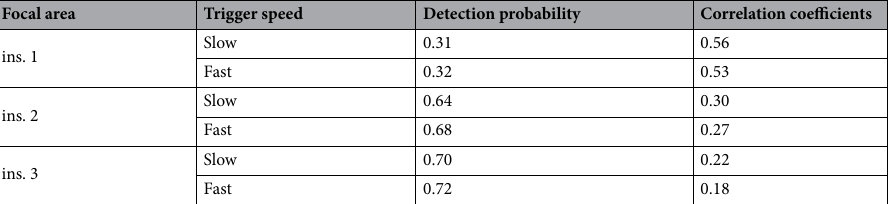
Table 2. Results of the simulations mimicking the process by which camera traps detect moving animals. In ins. 1, two camera traps were placed at the same position (i.e. mounted on the same tree) and monitored the entire field of view of the cameras. In ins 2 and 3, camera traps monitored a specific equilateral triangle with a side length of 1.7 m from the same direction (ins. 2) or from different angles of 60 degrees (ins. 3). For each installation, the uses of camera models with a fast trigger speed (0.1 s) and a slow one (1.5 s) were considered. Detection probability indicates the number of successful detections for the total number of animal passes (200 times). The mean value of the two cameras were shown. For the details, see the main